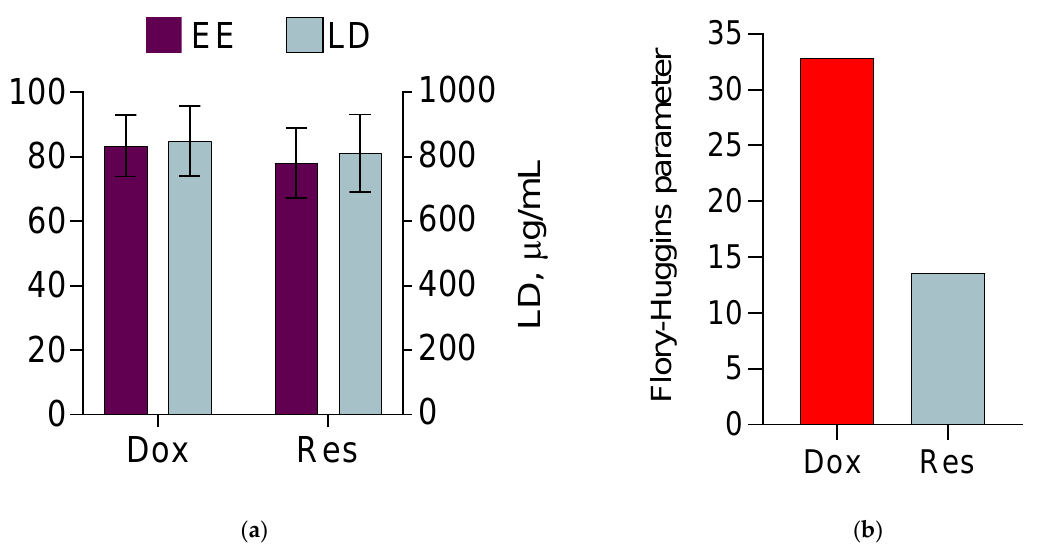
Figure 1. Encapsulation efficiency (EE) and loading degree (LD) in the double-loaded micelles ( a ) and Flory–Huggins parameter calculated for doxorubicin (Dox) and resveratrol (Res) with respect to PPO block ( b ).